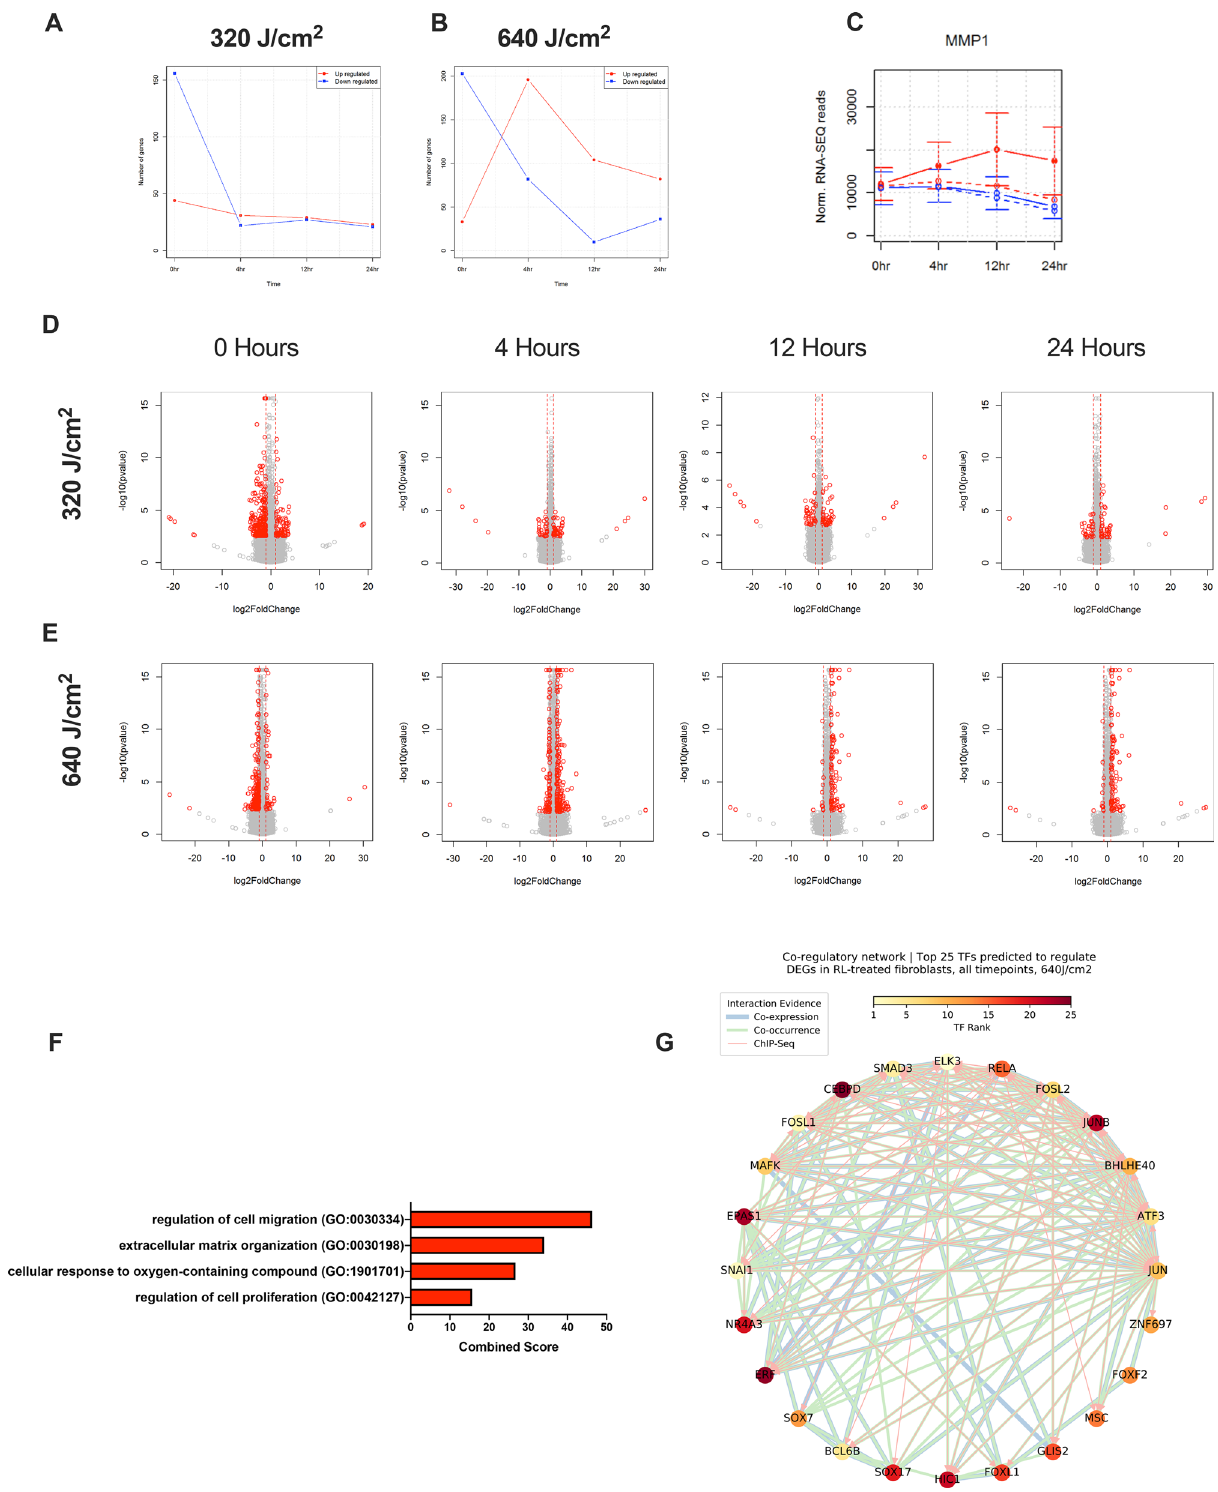
Figure 2. Transcriptomic and pathway enrichment profile of HDFs. The most considerable change in gene expression occurs between 0 and 4 h. (A) The number of up (red) and down (blue) DEGs by time for the 320 J/cm 2 and (B) 640 J/cm 2 fluences. (C) Representative expression profile of MMP1. Dashed and solid lines represent the 320 and 640 J/cm 2 fluences, respectively. Blue lines are control samples, and red lines are RL treated samples. (D) Volcano plots of DEGs following irradiation with 320 J/cm 2 and (E) 640 J/cm 2 fluences. Red dots are DEGs with FDR-adjusted p values < 0.05 and fold change > 2 or < 0.5. Grey dots have FDR-adjusted p values > 0.05 or fold change between 2 and 0.5. DESeq2 was used to calculate DEGs for 320 J/cm 2 and 640 J/cm 2 RL treated samples. The number of DEGs was calculated by averaging the results of all four donor samples. Differential expression analysis was performed for each time point and the p-values were corrected for multiple testing using the FDR method. (F) Enriched GO pathways of interest, in 640 J/cm 2 RL, all timepoints. (G) Co-regulatory networks of top 25 TF predicted to regulate differential expression in 640 J/cm 2 RL treated HDFs and pooled time